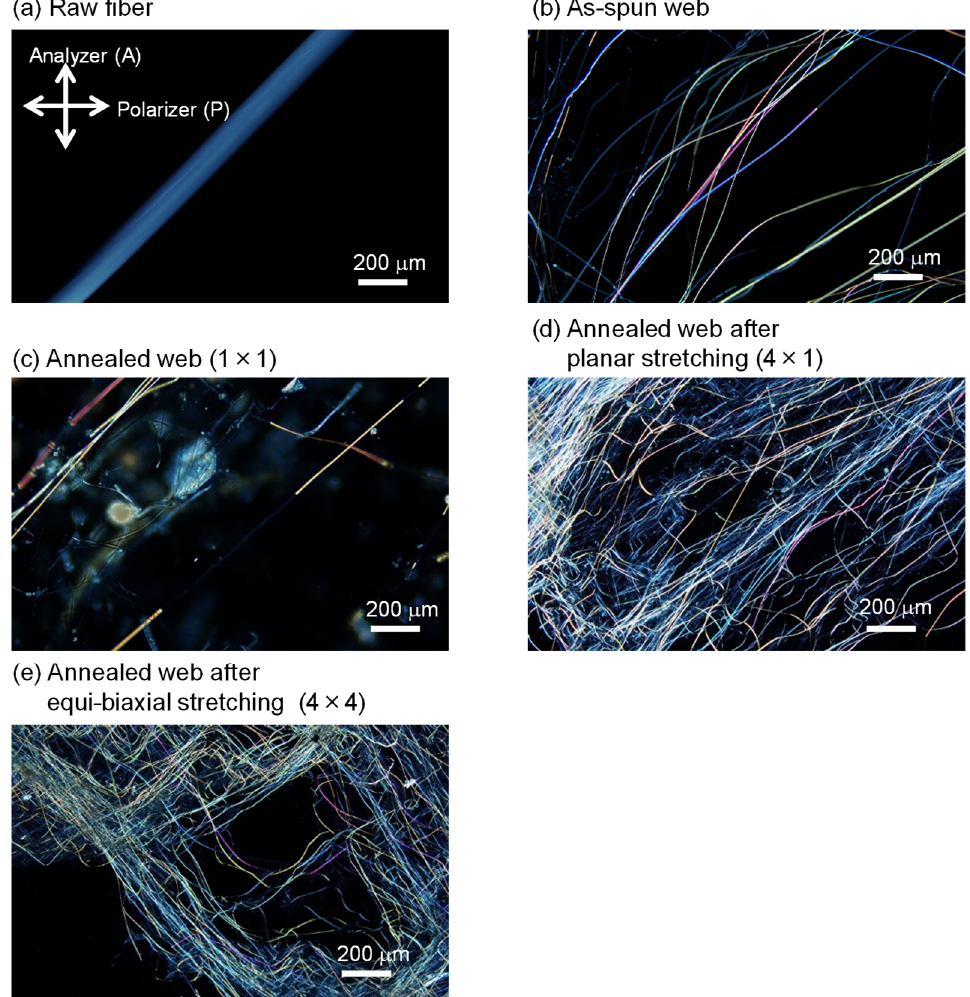
Figure 4. Micrographs of the fibers observed under a polarizing microscope with cross-polarization: ( a ) raw fiber for LES, ( b ) as-spun web, ( c ) annealed web (MD × TD = 1 × 1), ( d ) annealed web after planar stretching (MD × TD = 4 × 1), and ( e ) annealed web after simultaneous equibiaxial stretching (MD × TD = 4 × 4). Directions of polarization for a polarizer and an analyzer are indicated in ( a ).